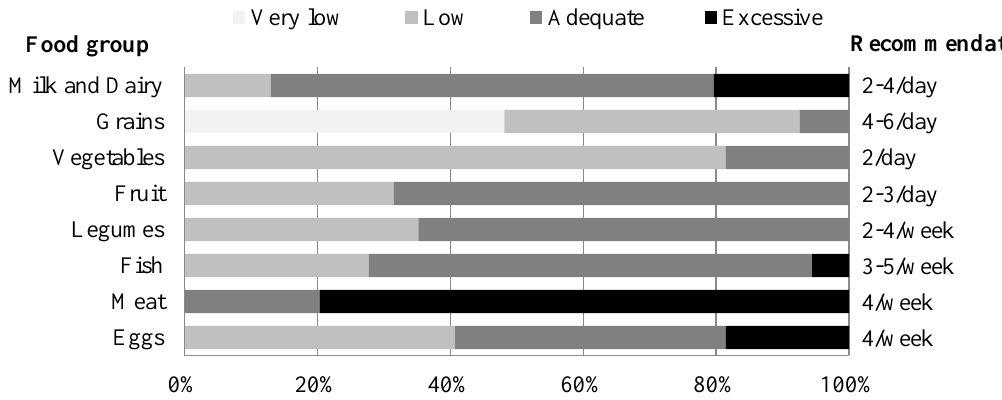
Figure 3. Compliance of food frequency consumption of celiac women by servings per day or week, according to Spanish Society of Community Nutrition (SENC).